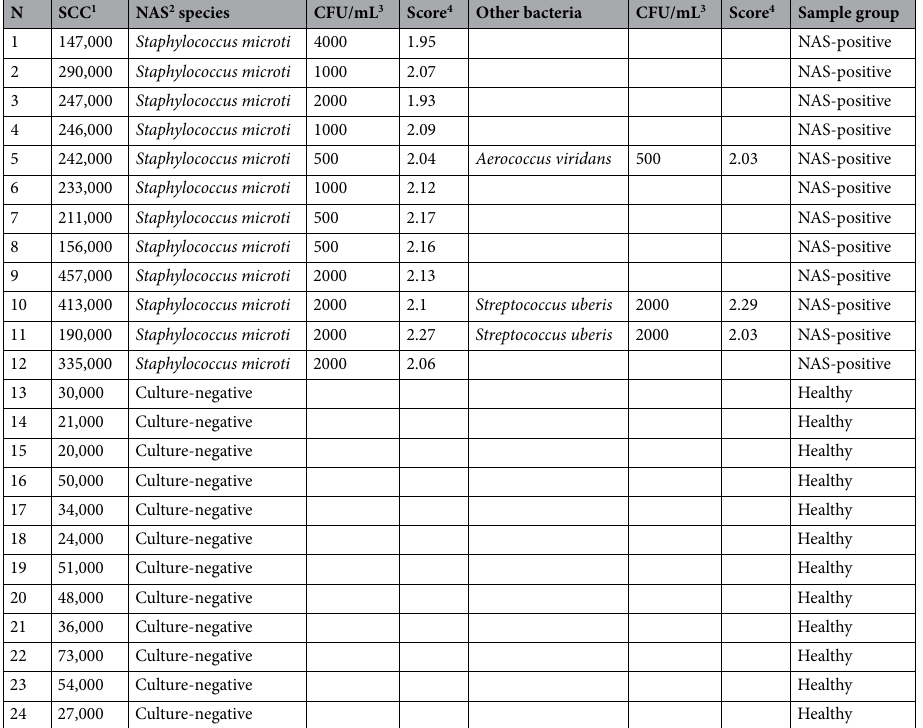
Table 1. Somatic cell count (SCC) and bacterial species identified in the quarter milk samples subjected to peptidomic analysis. The last column reports the sample classification according to SCC value and presence of NAS. Complete data are reported in Supplementary Table 1. 1 Somatic cell count in cells/mL of milk. 2 Non-aureus staphylococci. 3 Colony-forming units per mL of milk. 4 Log score of the species identification by